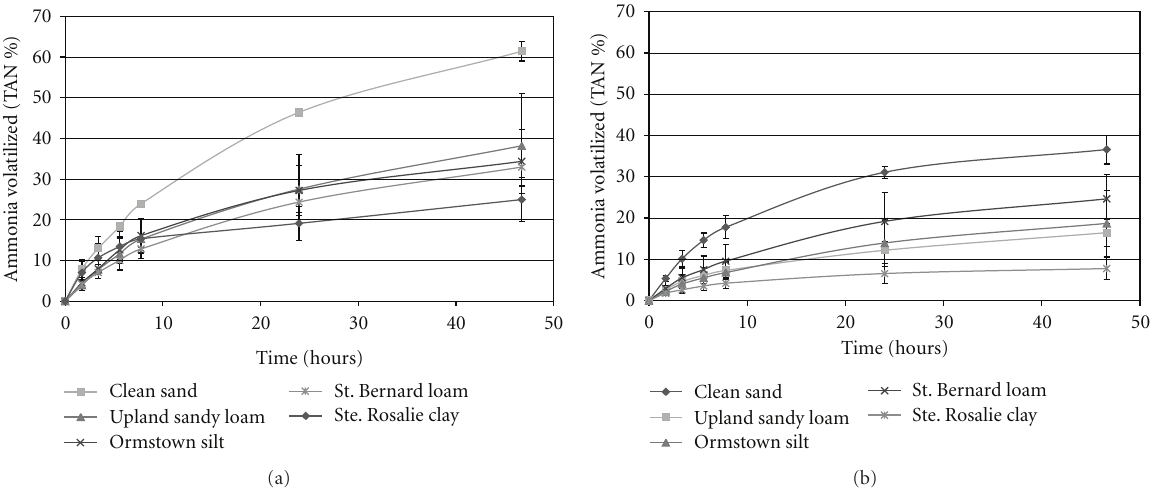
Figure 2: Cumulative NH 3 volatilized during 47 hours following the land application of untreated swine manure from the open tank (a) and anaerobically treated swine manure ISPAD (b). The NH 3 volatilization was measured using the laboratory wind tunnels. The data points are the average of n = 3 and the error bars represent ± one standard deviation.